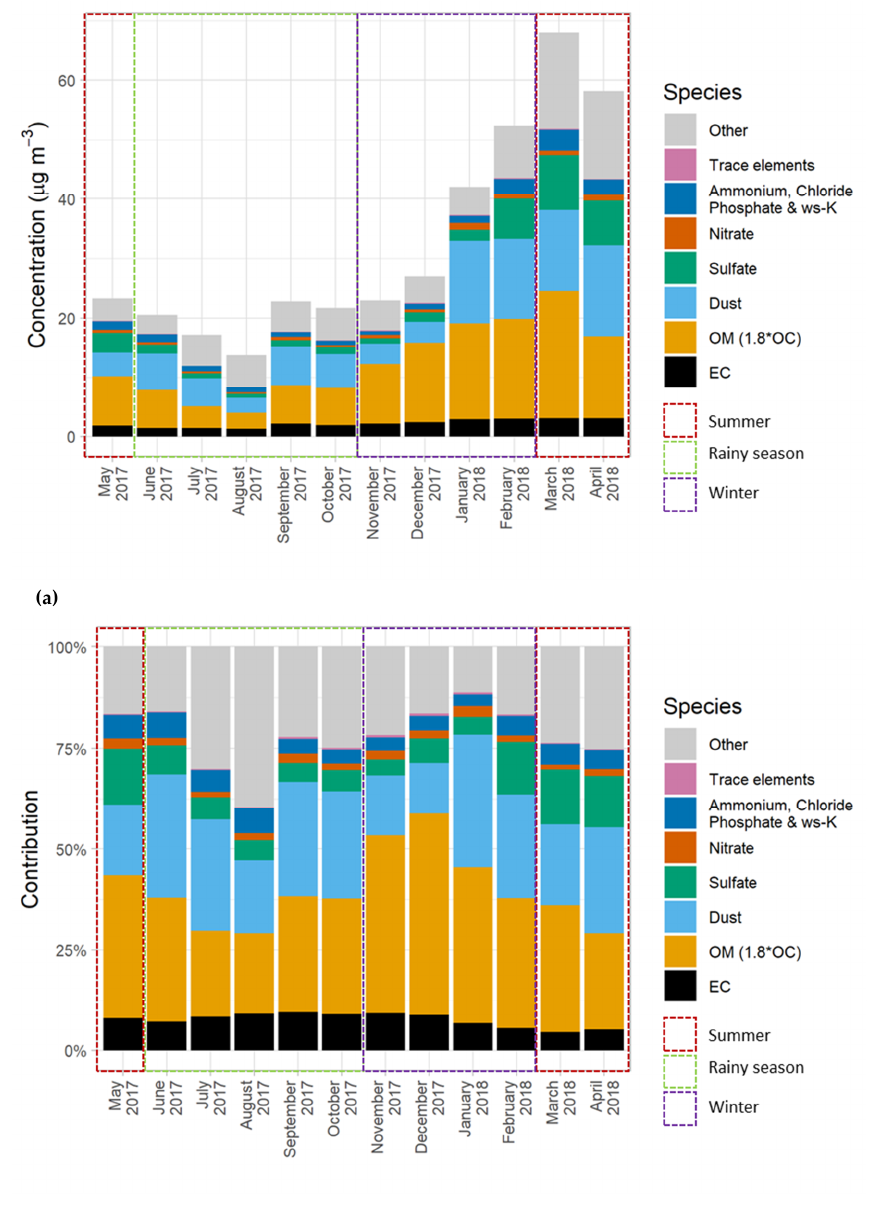
Figure 2. ( a ). Mass reconstructed concentrations of monthly PM 10 in Yangon, Myanmar. ( b ) Chemical Figure 2. (a). Mass reconstructed concentrations of monthly PM 10 in Yangon, Myanmar. (b) Chemical component contributions in monthly PM 10 in Yangon, component contributions in monthly PM 10 in Yangon, Myanmar.